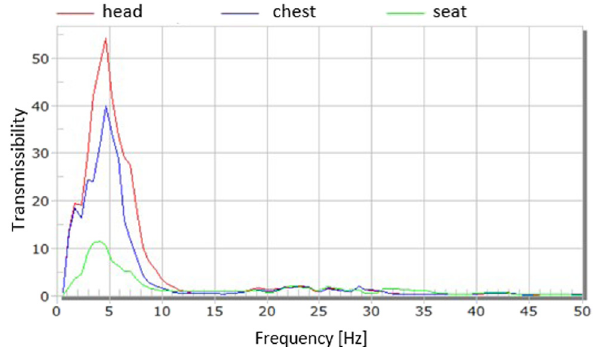
Figure 6: The range of transmissibility of the vertical vibrations of the whole body to the seat, chest, and head as a function of the frequency for the 15 Hz excitation.